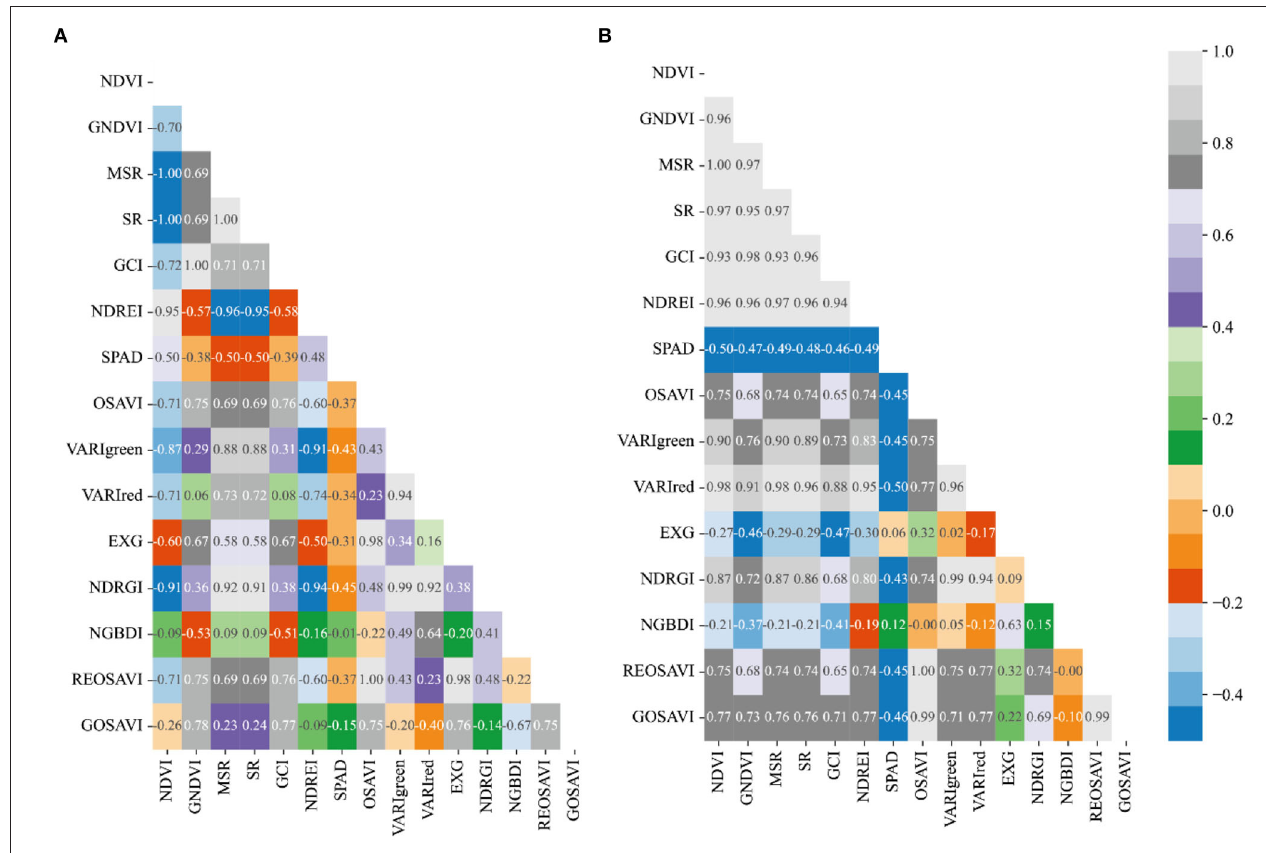
FIGURE 6 | Plot of correlation between different vegetation indices and CC of winter wheat during heading stage: (A) normal irrigation of Manas winter wheat during heading stage, and (B) water limited treatment of Manas winter wheat during heading stage. All vegetation indices that appear in the figure are explained in Table 3 .